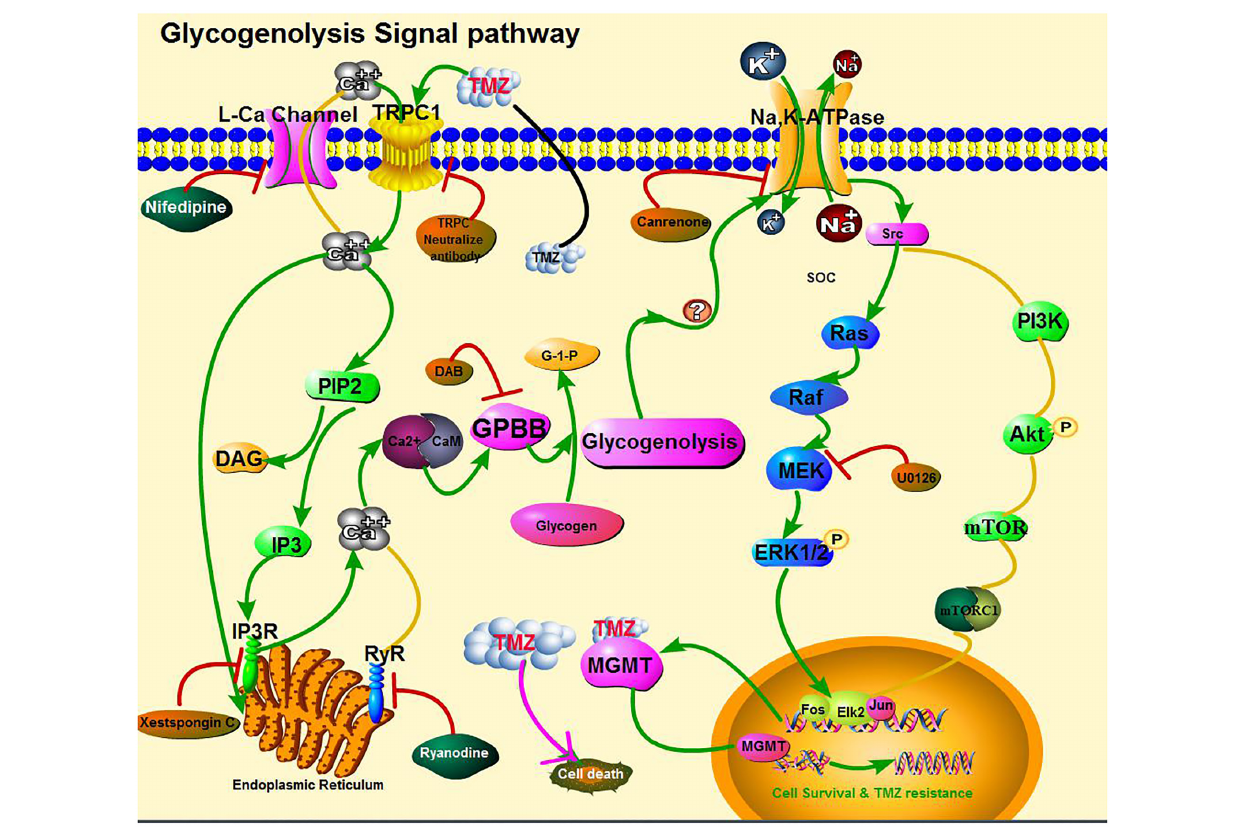
FIGURE 13 | Cartoon illustrating signaling pathways activated by temozolomide (TMZ) in glioma cells. TMZ plays a dual role by both (1) inhibiting cell proliferation (pink solid line) and (2) inducing acquired TMZ resistance via the upregulation of MGMT. The latter effect requires [Ca 2 + ] i -dependent glycogenolysis via the Na,K-ATPase/ERK 1 / 2 signaling pathway (green solid lines). Activation of the second pathway leads to an increase in [Ca 2 + ] i by TRPC1 in the cell membrane and IP3R in the ER, which act upon the intracellular Ca 2 + -sensitive site of calmodulin (CaM) protein, possibly activating glycogen phosphorylase activation and the subsequent stimulation of glycogenolysis, necessary for pathway function. The ouabain signaling pathway is shown at the top of the figure. Na,K-ATPase was activated possibly by glycogenolysis and trans-activated by the MAPK pathway, which was confirmed by our own previous studies and our current inhibitor studies. Inhibitory effects on the upregulation of MGMT expression, after addition of TMZ, are shown in brown ovals. No effect of other inhibitors on [Ca 2 + ] i release and upregulation of Na,K-ATPase, ERK 1 / 2 , and MGMT are shown in green